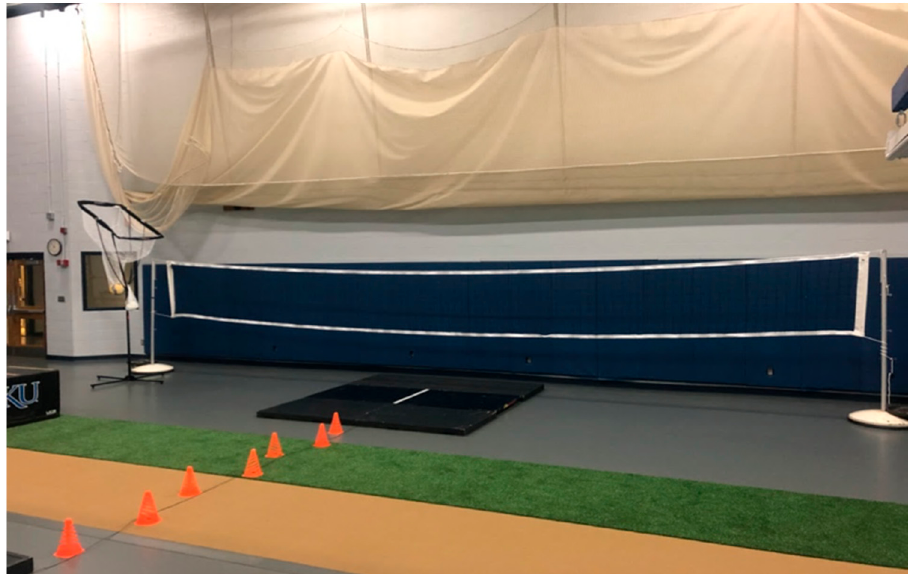
Figure 1. The experimental setup.